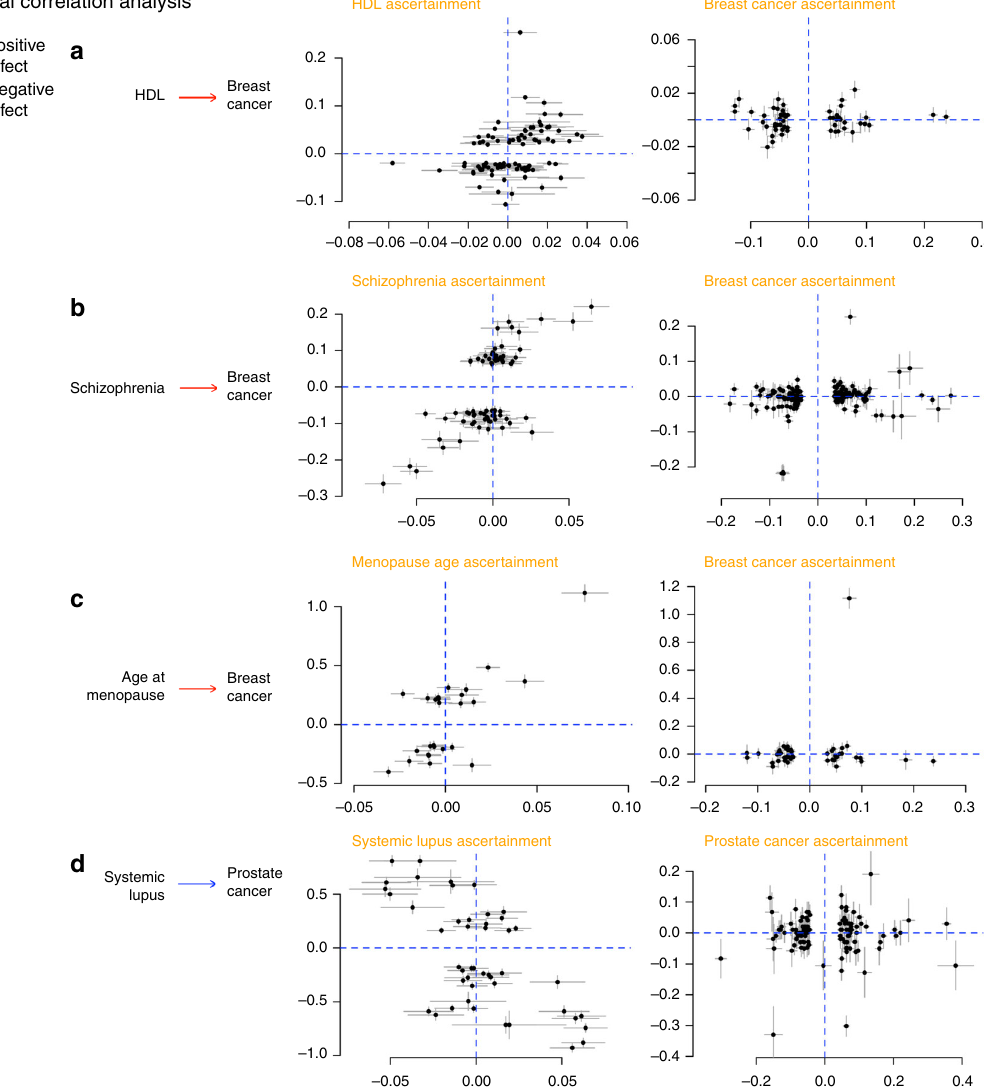
Fig. 4 Putative directional relationships between cancers and traits. For each cancer – trait pair identi fi ed as candidates to be related in a causal manner, the plots show trait-speci fi c effect sizes (beta coef fi cients) of the included genetic variants. Gray lines represent the relevant standard errors. a HDL and breast cancer. Trait-speci fi c effect sizes for HDL and breast cancer are shown for SNPs associated with HDL levels (left) and breast cancer (right). b Schizophrenia and breast cancer. Trait-speci fi c effect sizes for schizophrenia and breast cancer are shown for SNPs associated with schizophrenia (left) and breast cancer (right). c Age at natural menopause and breast cancer. Trait-speci fi c effect sizes for age at natural menopause and breast cancer are shown for SNPs associated with age at natural menopause (left) and breast cancer (right). d Lupus and prostate cancer. Trait-speci fi c effect sizes for lupus and prostate cancer are shown for SNPs associated with lupus (left) and prostate cancer